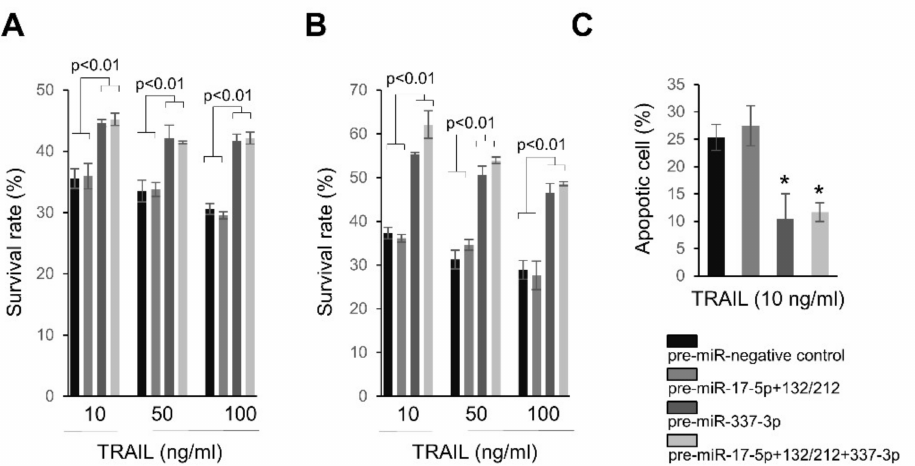
Figure 6. Ectopic expression of miRNAs targeting caspases-3 and caspase-7 renders PANC-1 cells resistant to TRAIL. ( A ) PANC-1 cells were transfected either pre-miR-nega (100 nM), pre-miR-17-5p (50 nM) + a mixture of pre-miR-132-3p and -212-3p (50 nM), pre-miR-337-3p (100 nM), or pre-miR-17-5p (25 nM) + a mixture of pre-miR-132-3p and -212-3p (25 nM) + pre-miR-337-3p (50 nM) in 96 well plates. At 72 h after transfection, TRAIL was treated for 24 h followed and survival rates were measured using WST1 assay. ( B ) Treatment conditions were the same as in ( A ) except that final concentrations of oligos were 150 nM (pre-miR-negative control (150 nM), pre-miR-17-5p (75 nM) + a mixture of pre-miR-132-3p and -212-3p (75 nM), pre-miR-337-3p (150 nM), or pre-miR-17-5p + a mixture of pre-miR-132-3p and -212-3p (75 nM) + pre-miR-337-3p (75 nM)) in 96 well plates. ( C ) Under same transfection conditions in ( B ), apoptotic cells were evaluated by Annexin-FITC assay 12 h after treatment 10 ng/mL TRAIL